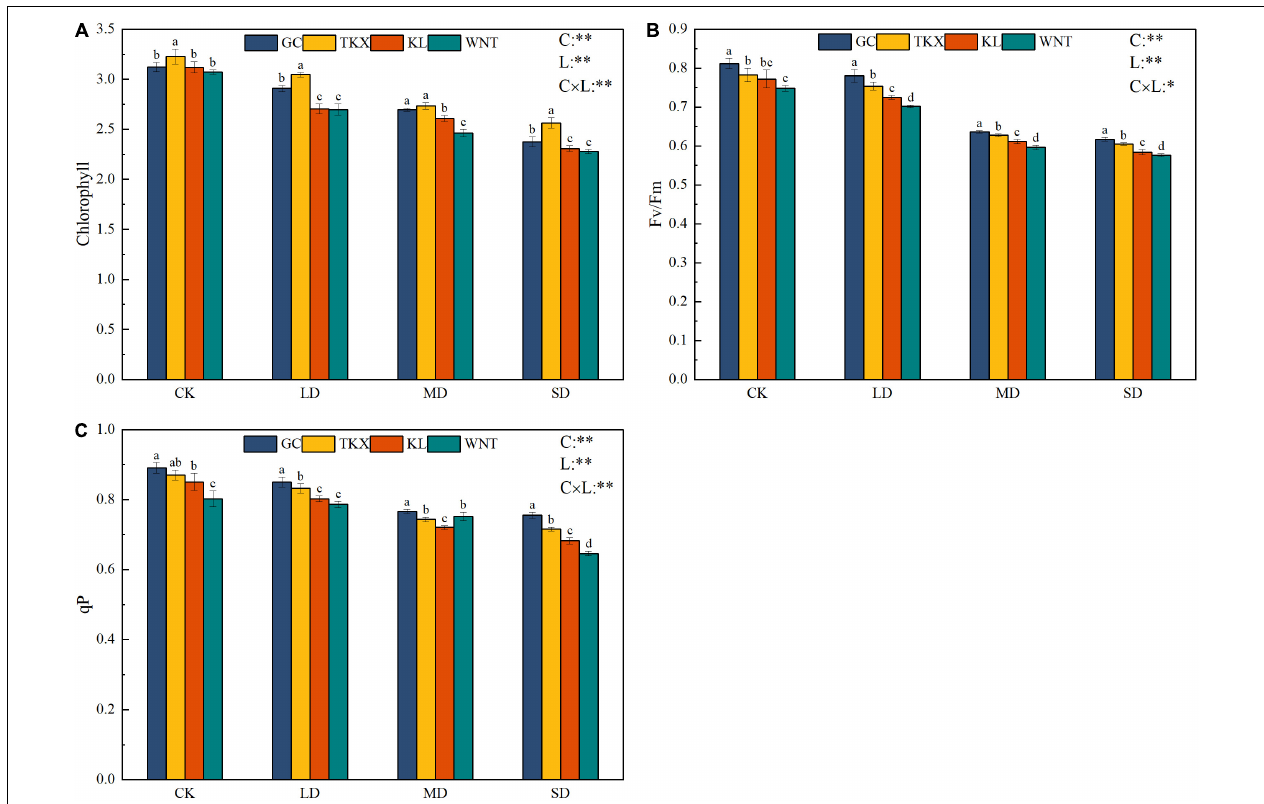
FIGURE 3 | Effects of drought stress on the photosynthetic characteristics of different geographical populations of Solanum rostratum . Changes in leaf chlorophyll (A) , maximal chemical efficiency ( F v / F m ) (B) , and dynamics of photochemical quenching ( q P) (C) of S. rostratum under different drought-stress concentrations. The blue column represents the GC site, yellow column represents the TKX site, red column represents to KL site, and green column represents the WNT site. Different lowercase letters indicate a significant difference under drought stress in S. rostratum populations, according to Duncan’s test ( α = 0.05). C refers to the differences among drought-stress concentrations; L refers to the differences among each geographical population; C × L refers to the interaction between populations and concentration. The significant change in functional traits between the four collection sites was shown by the significance of population–stress treatment interactions. Asterisks indicate a significant difference (*, p ≤ 0.05; **, p ≤ 0.01; ***, p ≤ 0.001). Refer to statistics in Supplementary Table 1